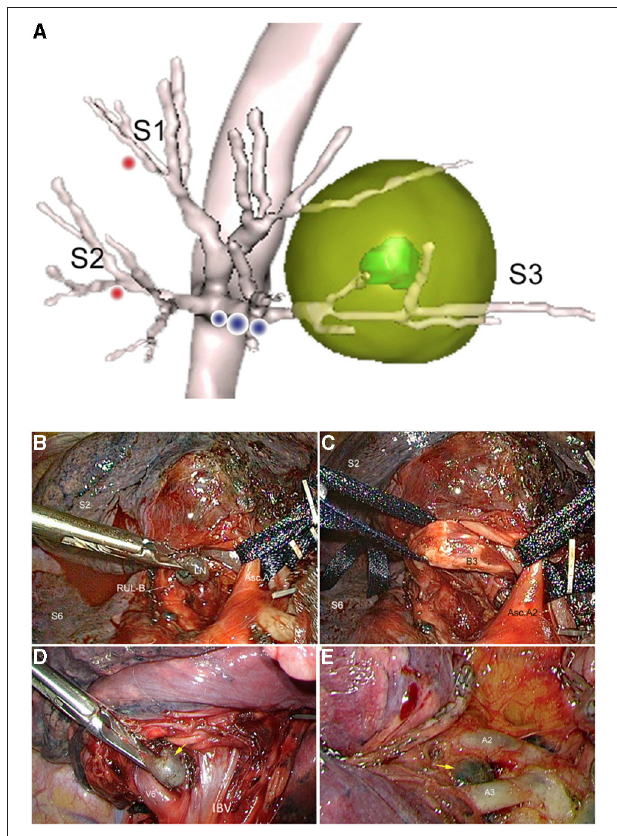
FIGURE 1 | S 3 Segmentectomy for a cT1aN0M0 NSCLC and examples of adjacent lymph nodes requiring intraoperative examination. (A) Schematic view based on 3D reconstruction (green mass = target nodule, pale yellow sphere = virtual safety margin, yellow dots = aLNs, red dots = iSLs). (B) Intraoperative view of aLNs hiding B 3 bronchus, (C) Intraoperative view after LN clearance. RUL-B, right upper lobe bronchus; LN, Lymph node; Asc.A2, ascending A 2 artery. (D) Suspicious LN adjacent to V 6 during a planned right S 6 segmentectomy. (E) Suspicious LN adjacent to A 3 b during a planned left S 2